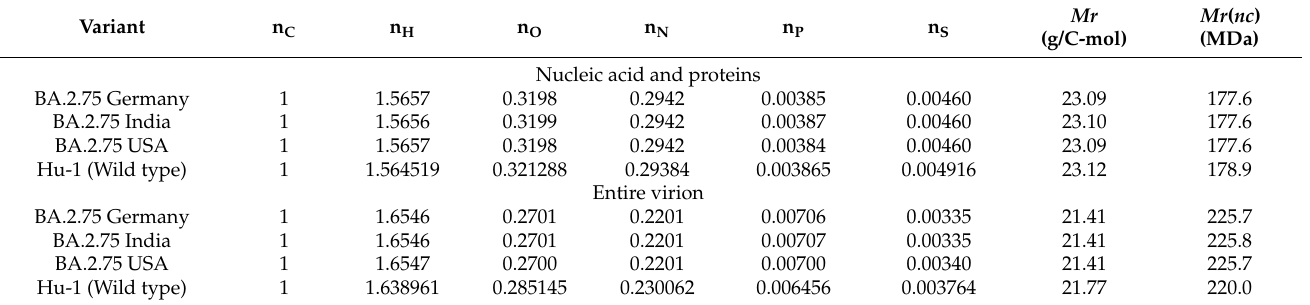
Table 5. Empirical formulas and molar masses of the SARS-CoV-2 nucleic acid and proteins and entire virions. Nucleic acids and proteins represent the viral RNA together with nucleoprotein, membrane proteins, and spike protein. On the other hand, the entire virion includes nucleic acid, proteins, and envelope lipids. Empirical formulas have the general form C nC H nH O nO N nN P nP S nS . Molar masses are reported in two forms. The first form is the molar mass of the empirical formula, Mr , with the units in g/C-mol (Da). The second is the molar mass of the entire nucleic acid and all protein copies, or entire virion, Mr ( nc ), expressed in MDa.